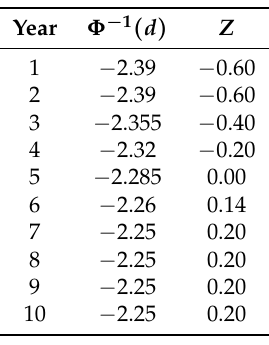
Table 4. Probit-transformed global default rate and corresponding value of Z